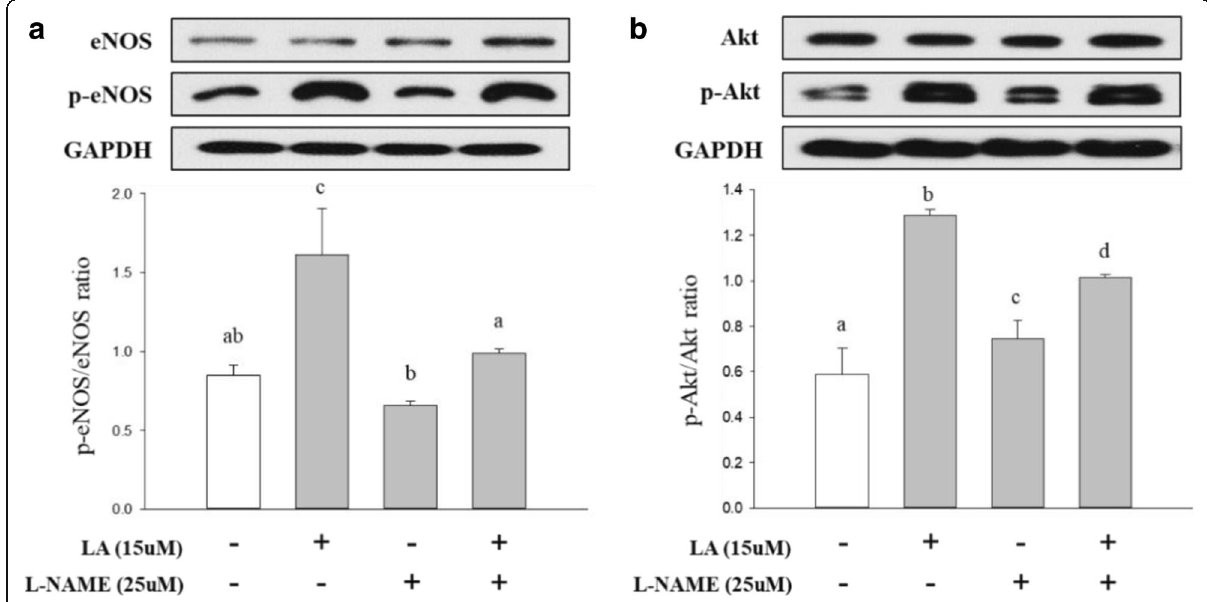
Fig. 3 Effects of LA on endothelial NO synthase (eNOS) phosphorylation in HUVECs. HUVECs treated with LA (15 μ M) for 20 min and co-incubated with or without L-NAME (25 μ M) for 24h, after which total lysates of cells were obtained by RIPA buffer containing protease inhibitors and phosphatase inhibitors. a LA treatment of phospho-eNOS and total eNOS, and ( b ) LA treatment of phospho-Akt and total Akt from HUVECs stimulated with LA. Different letters indicate a statistically significant difference between each group at * P <0.05, as determined by Duncan ’ s multiple-range